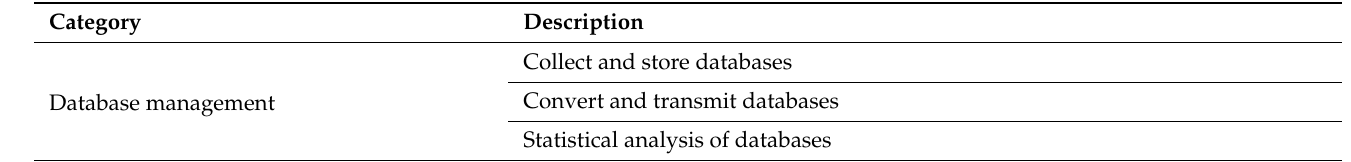
Table 6. Functional requirements of an underground utility tunnel digital